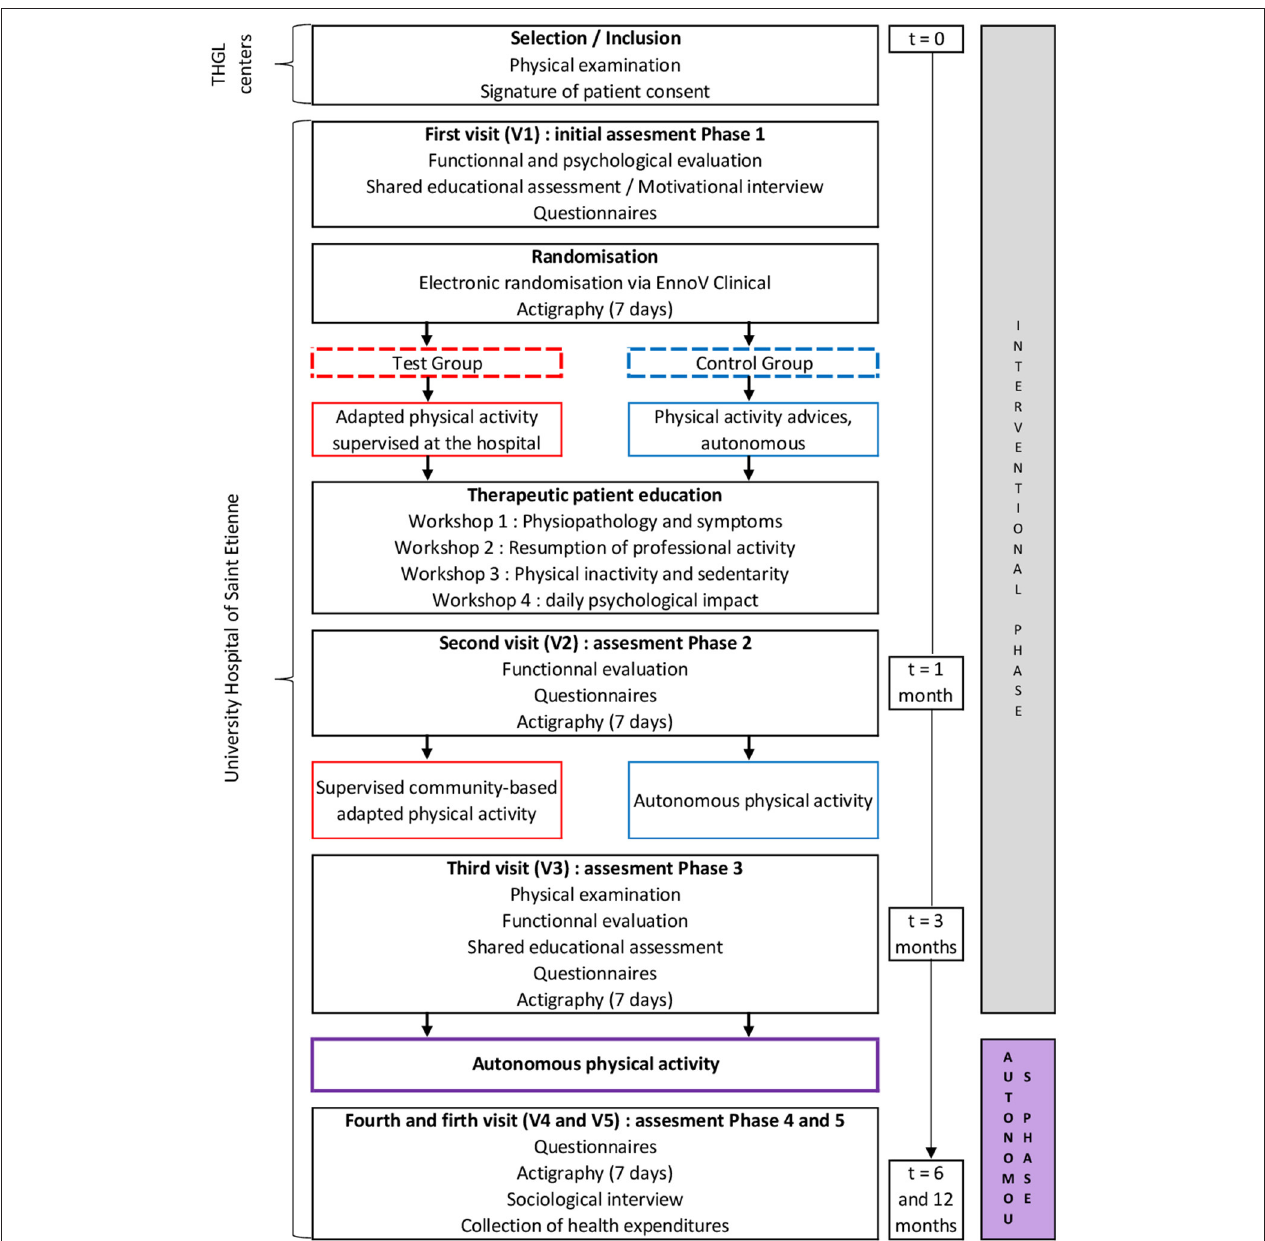
FIGURE 1 | Study design of Fimouv. THGL, Territorial Hospital Group of